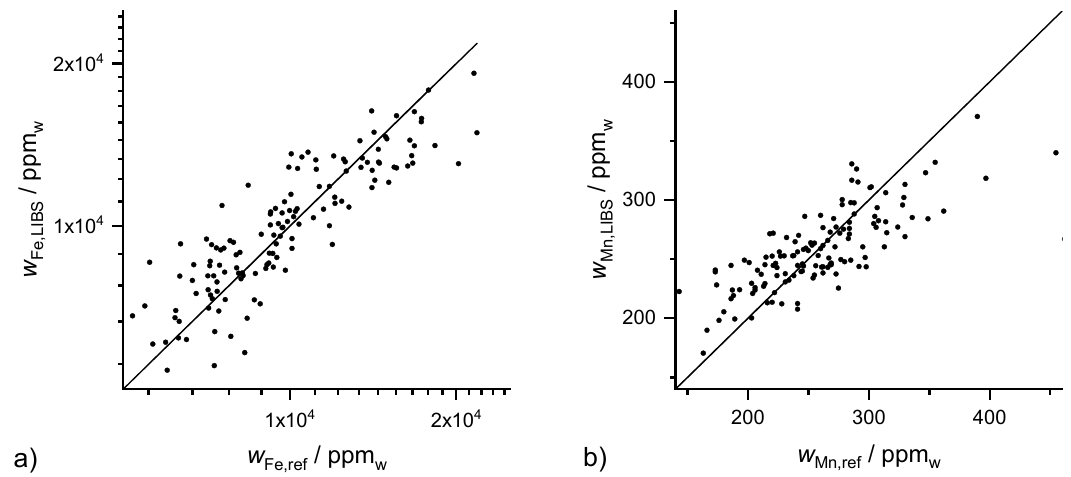
Figure 5. Results of 10-fold Lasso cross validation for ( a ) Fe with R 2 (Fe, Lasso) = 0.76 and ( b ) Mn with R 2 (Mn, Lasso) = 0.55.